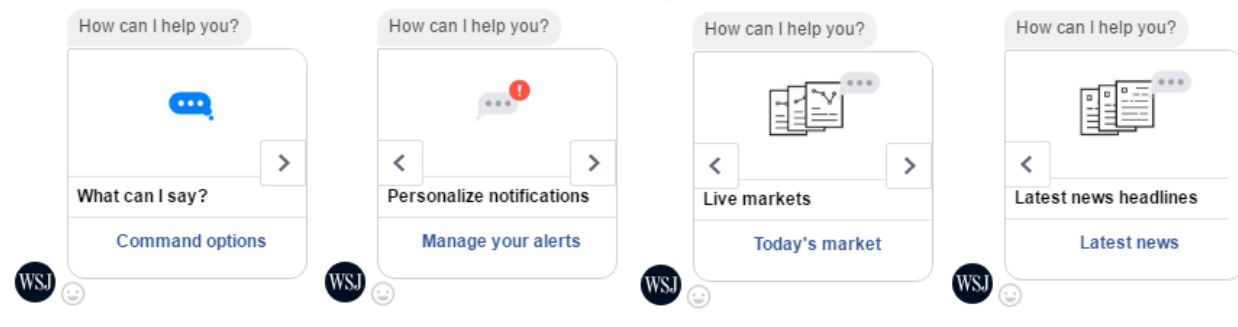
Fig. 10. WSJ’s main menu carousel.